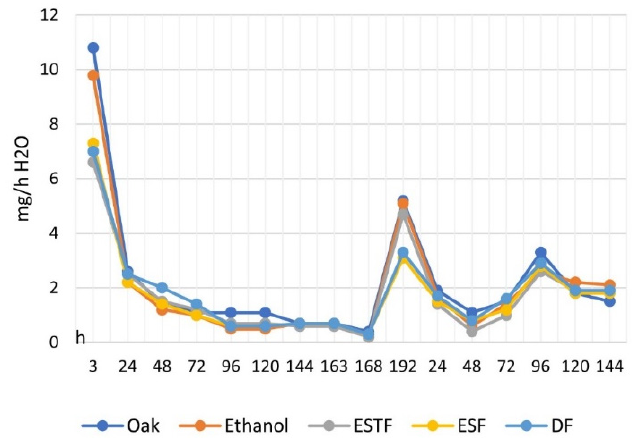
Figure 9. Variation of water vapor absorption over time at different RH values for oak sample, oak sample after ethanol extraction, and oak samples after coating with ESTF, ESF, or DF. Table 7. Total mass of water absorbed at different RH values and mass per unit of weight of the sample